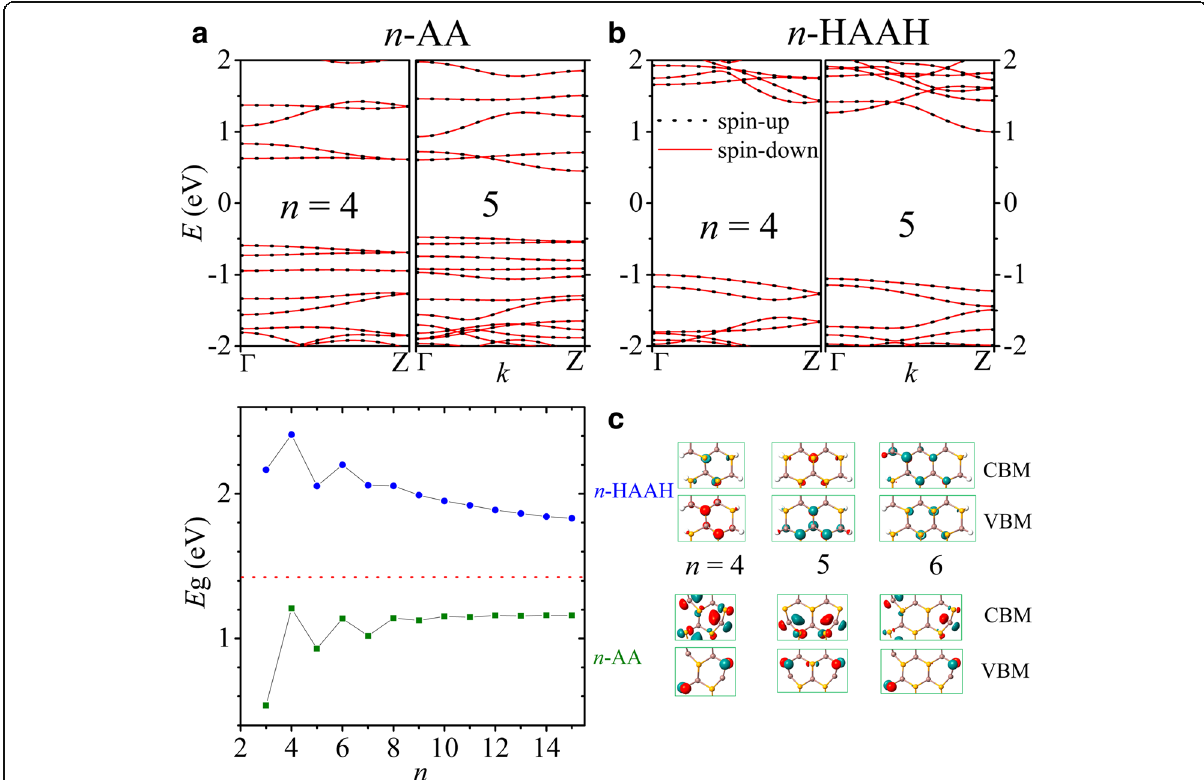
Fig. 5 The band structures of 4- and 5-AA nanoribbons are shown in a and those of 4- and 5-HAAH in b . The energy gaps E g of n -AA (green) and n -HAAH (blue) nanoribbons are plotted versus n in c with the gap of InSe monolayer (red) marked. The Bloch states at CBM and VBM for n = 4, 5, and 6 are shown in the right panels of